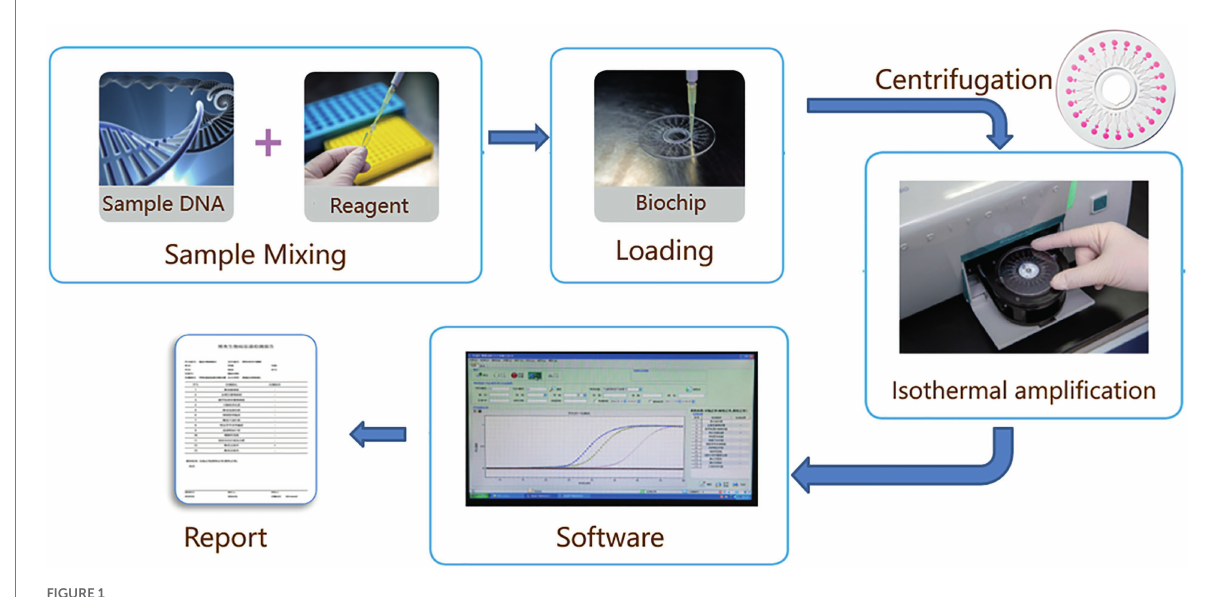
FIGURE 1 Experimental setup using the RTisochip amplification system.